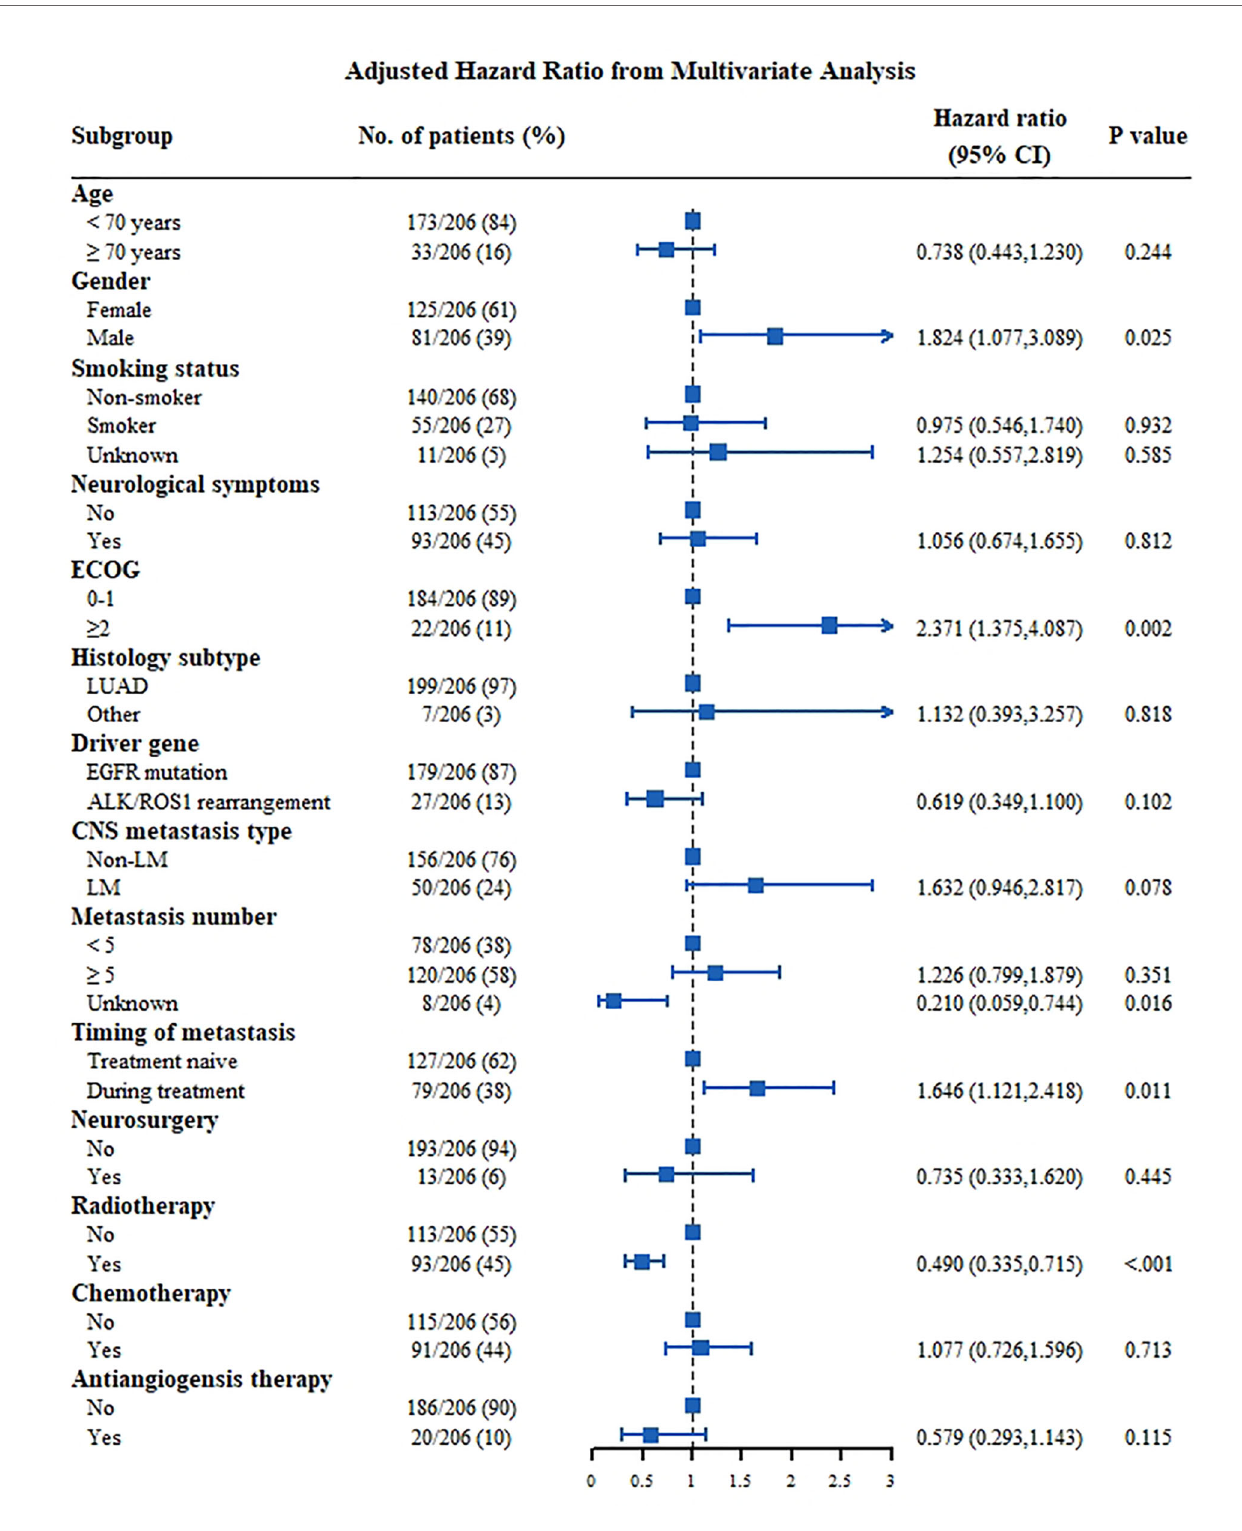
FIGURE 4 | Multivariate analysis Cox proportional hazards for OS in NSCLC patients with CNS metastasis of positive driver genes group. ALK, anaplastic lymphoma kinase; CNS, central nervous system; ECOG, Eastern Cooperative Oncology Group; EGFR, epidermal growth factor receptor; LM, leptomeningeal metastasis; LUAD, lung adenocarcinoma; LUSC, squamous cell lung